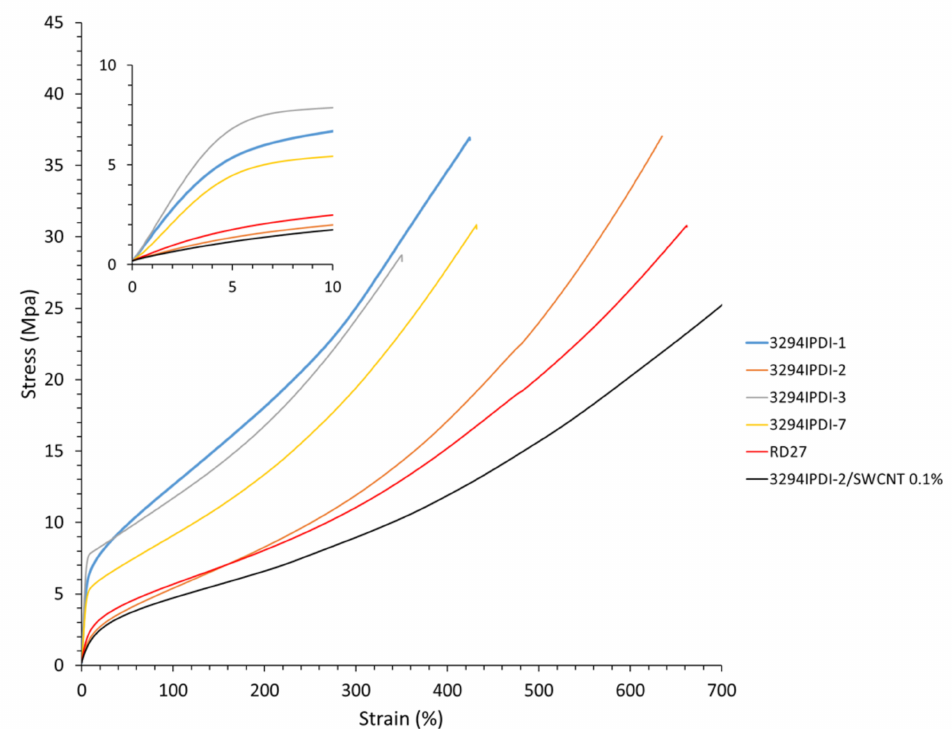
Figure 12. Stress–strain curves of WPUD films. Commercial non-biobased polyurethane (RD27) and polyurethane matrix 3294IPDI-2 additivated with 0.1 wt. % SWCNT (3294IPDI-2/SWCNT 0.1%) has been included for